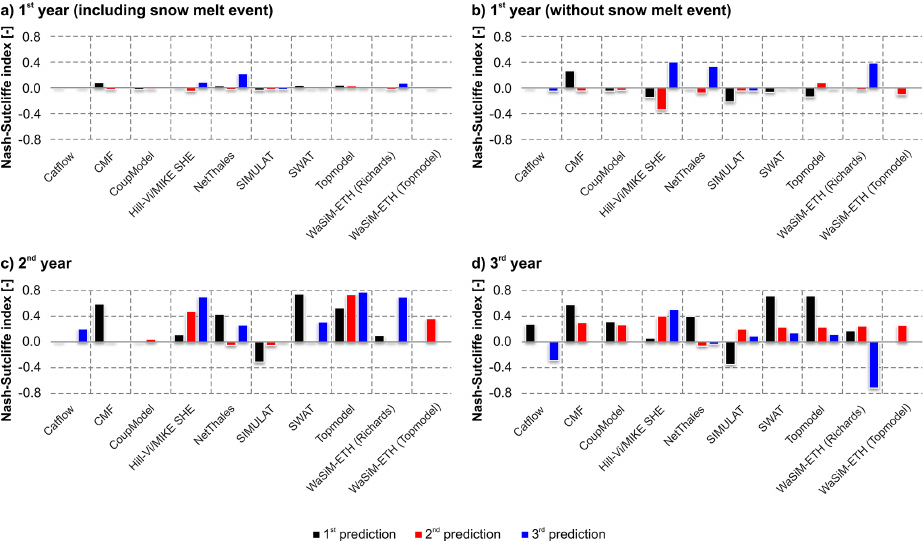
Figure 9. Nash–Sutcliffe index of each simulated discharge prediction against the observed discharge for (a) the first year including the snowmelt event, (b) the first year without the snowmelt event, (c) the second year, and (d) the third